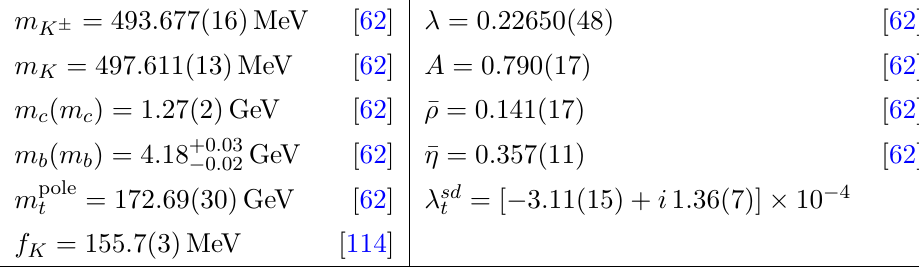
Table 3 . Input parameters used in this